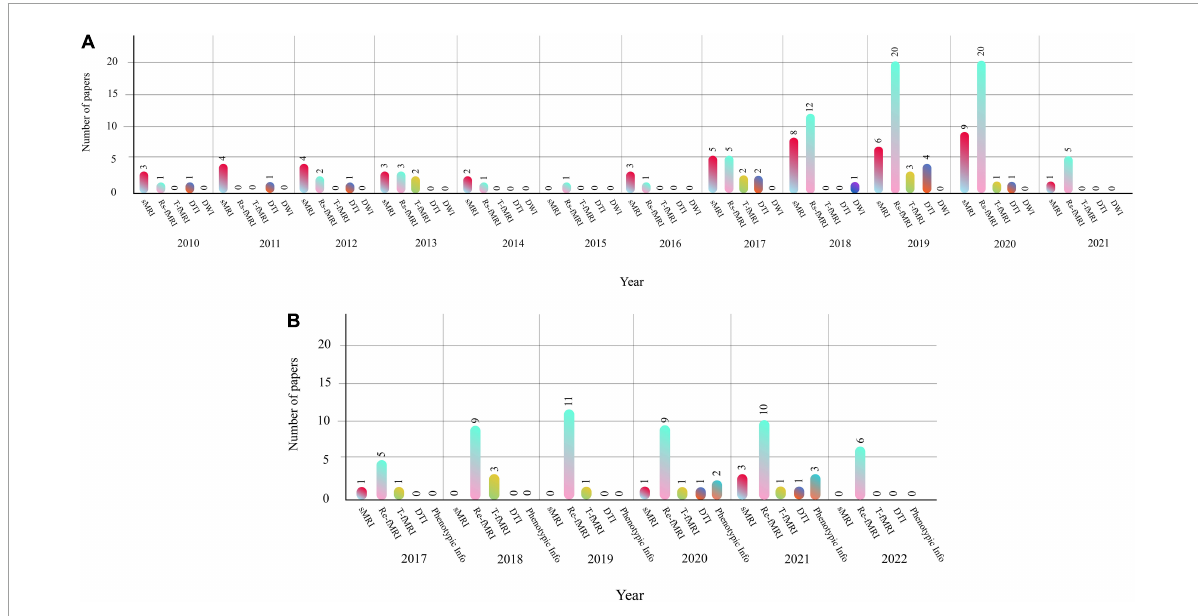
FIGURE6 (A) Shows the number of MRI neuroimaging modalities used in the CADS based on ML methods. (B) Shows the number of MRI neuroimaging modalities used in the CADS based on DL